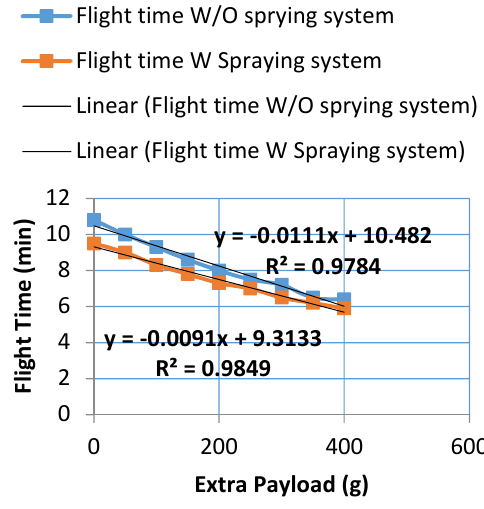
FIG.7: FLIGHT TIME AS A FUNCTION OF PAYLOAD FOR UAV WITHOUT SPRAYING SYSTEM AND WITH ACTIVE SPRAYING